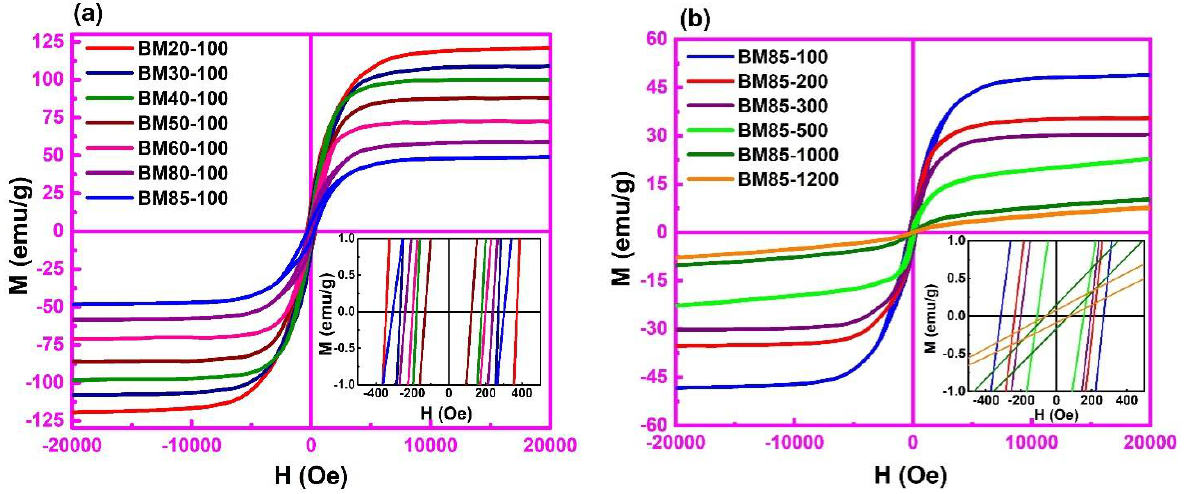
Figure 7. Room temperature hysteresis loops of ( a ) Co 100 − x Ni x NPs milled for 100 min and ( b ) Co 15 Ni 85 NPs milled for 100, 200, 300, 500, 1000, 1200 min. The inset shows the zoomed-in pictures of low-applied-magnetic-field